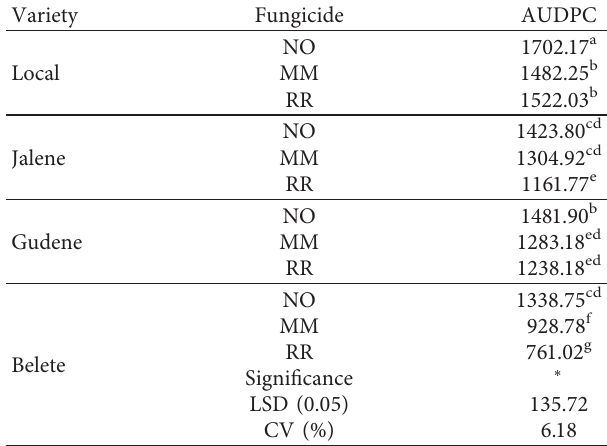
Table 4: Interaction effects of fungicides and potato varieties on late blight AUDPC.